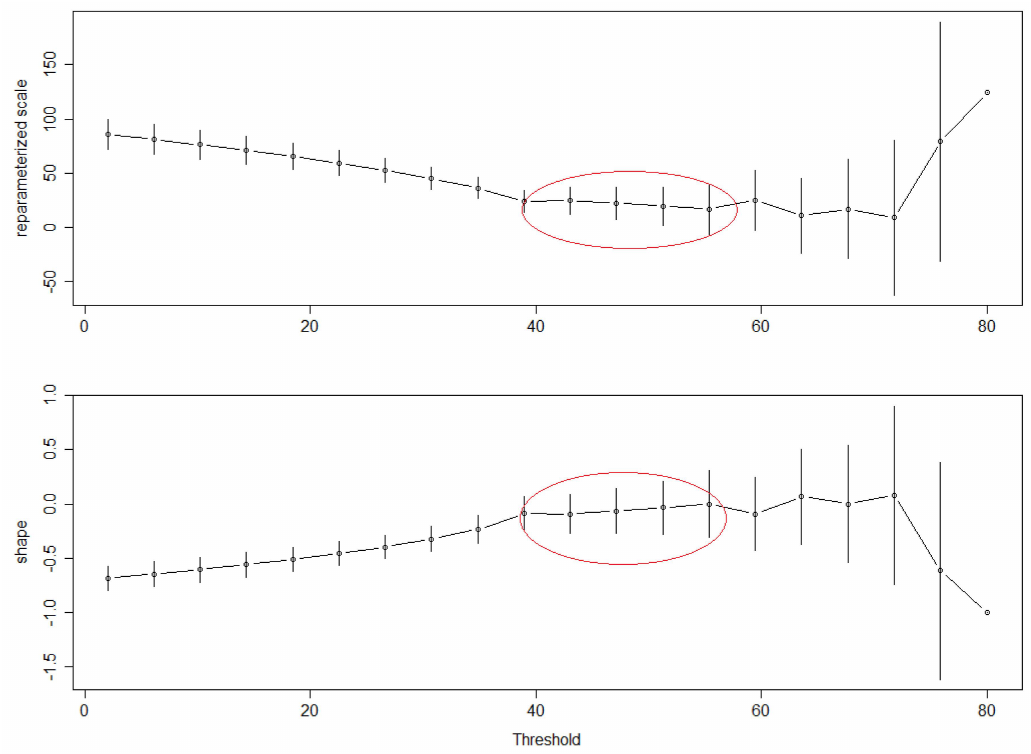
Figure A1. Parameter estimates against threshold for daily rainfall data at Agouna station.